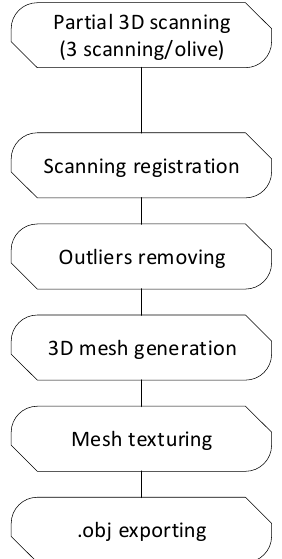
Figure 3. General scanning workflow.